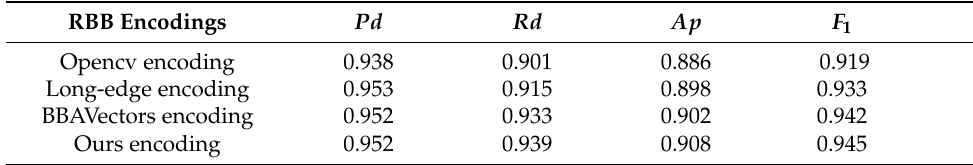
Table 1. Experimental Results of the Different RBB Encodings.